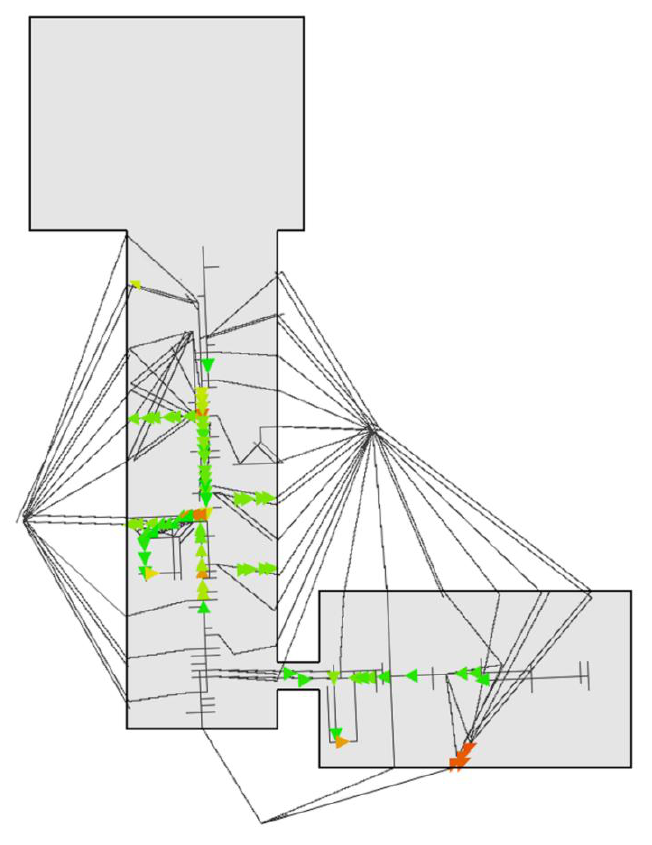
Figure 6. Visualization of the evacuation simulation Scenario 2 in its early progress after 10